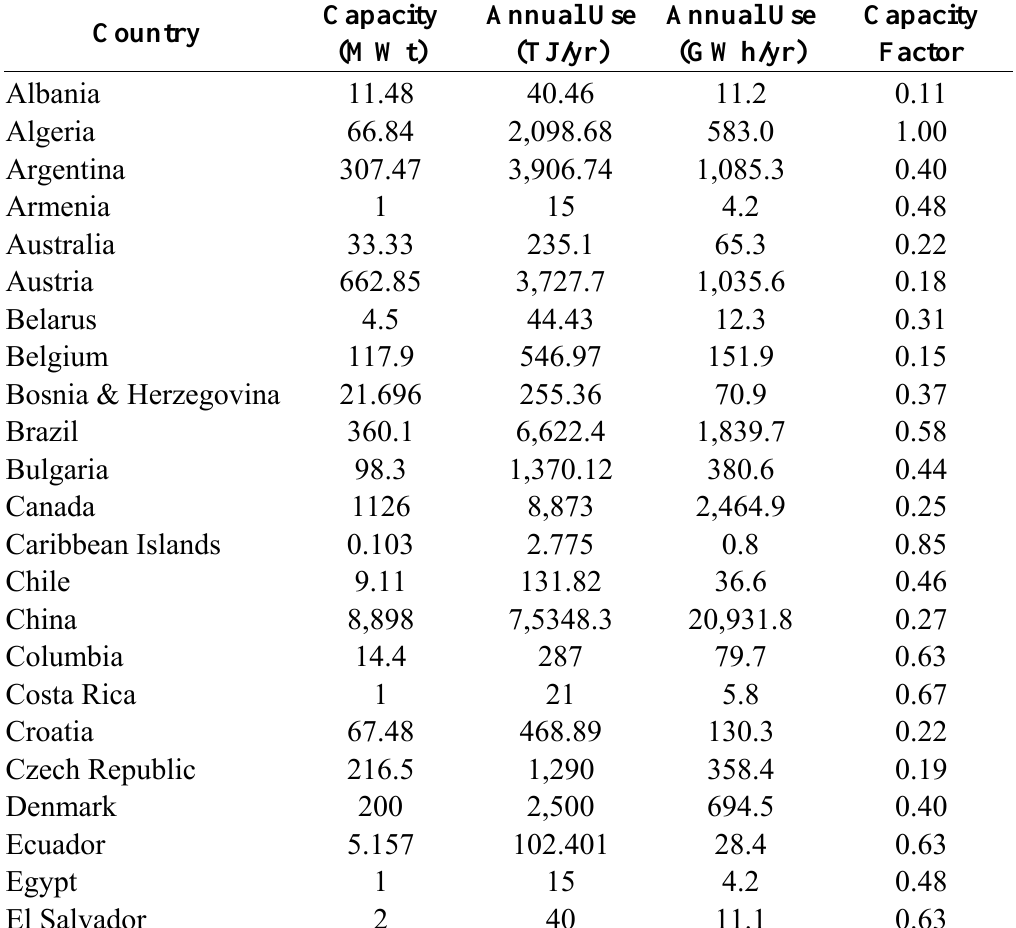
Table 1. Summary of direct-use data worldwide, 2010